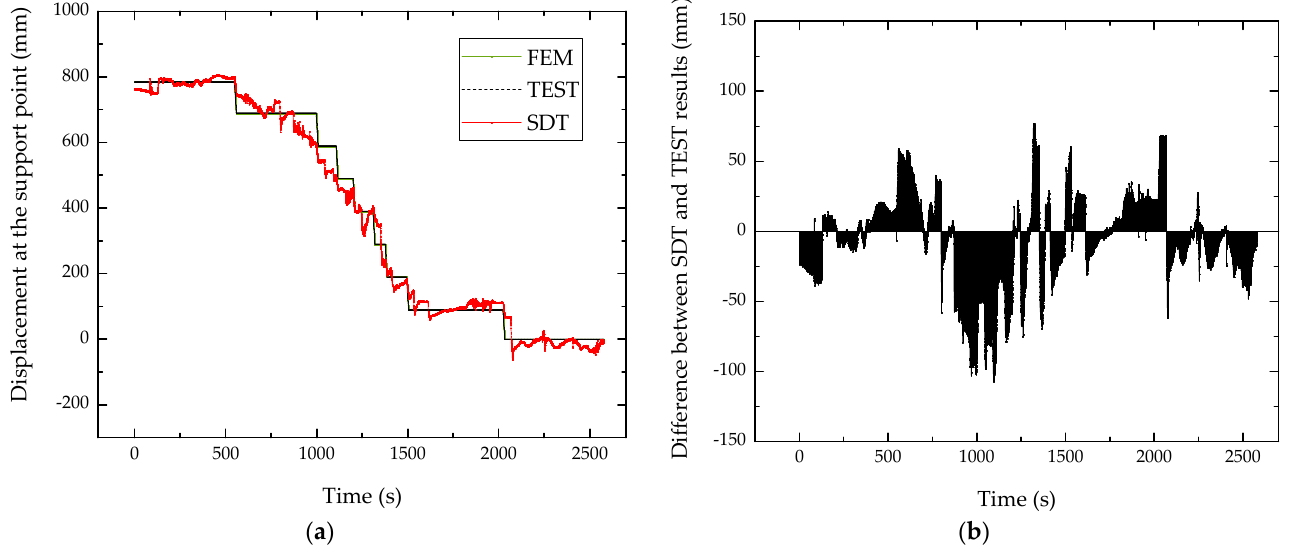
Figure 14. ( a ) Displacement responses at the support point; ( b ) difference between SDT and TEST results.